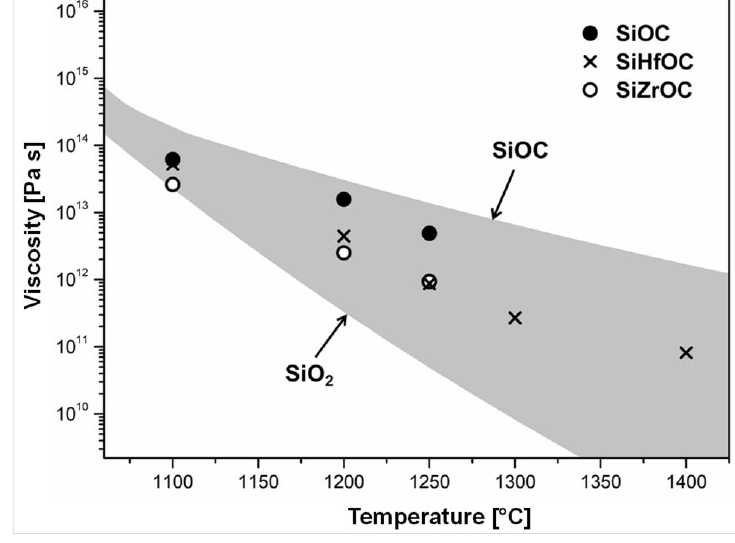
Figure 17. Viscosity of SiOC, SiZrOC, and SiHfOC as a function of temperature. The upper border of the gray region represent the temperature evolution of the viscosity of SiOC; whereas the lower border describes the evolution of the viscosity for vitreous silica (reprinted with permission from Wiley)